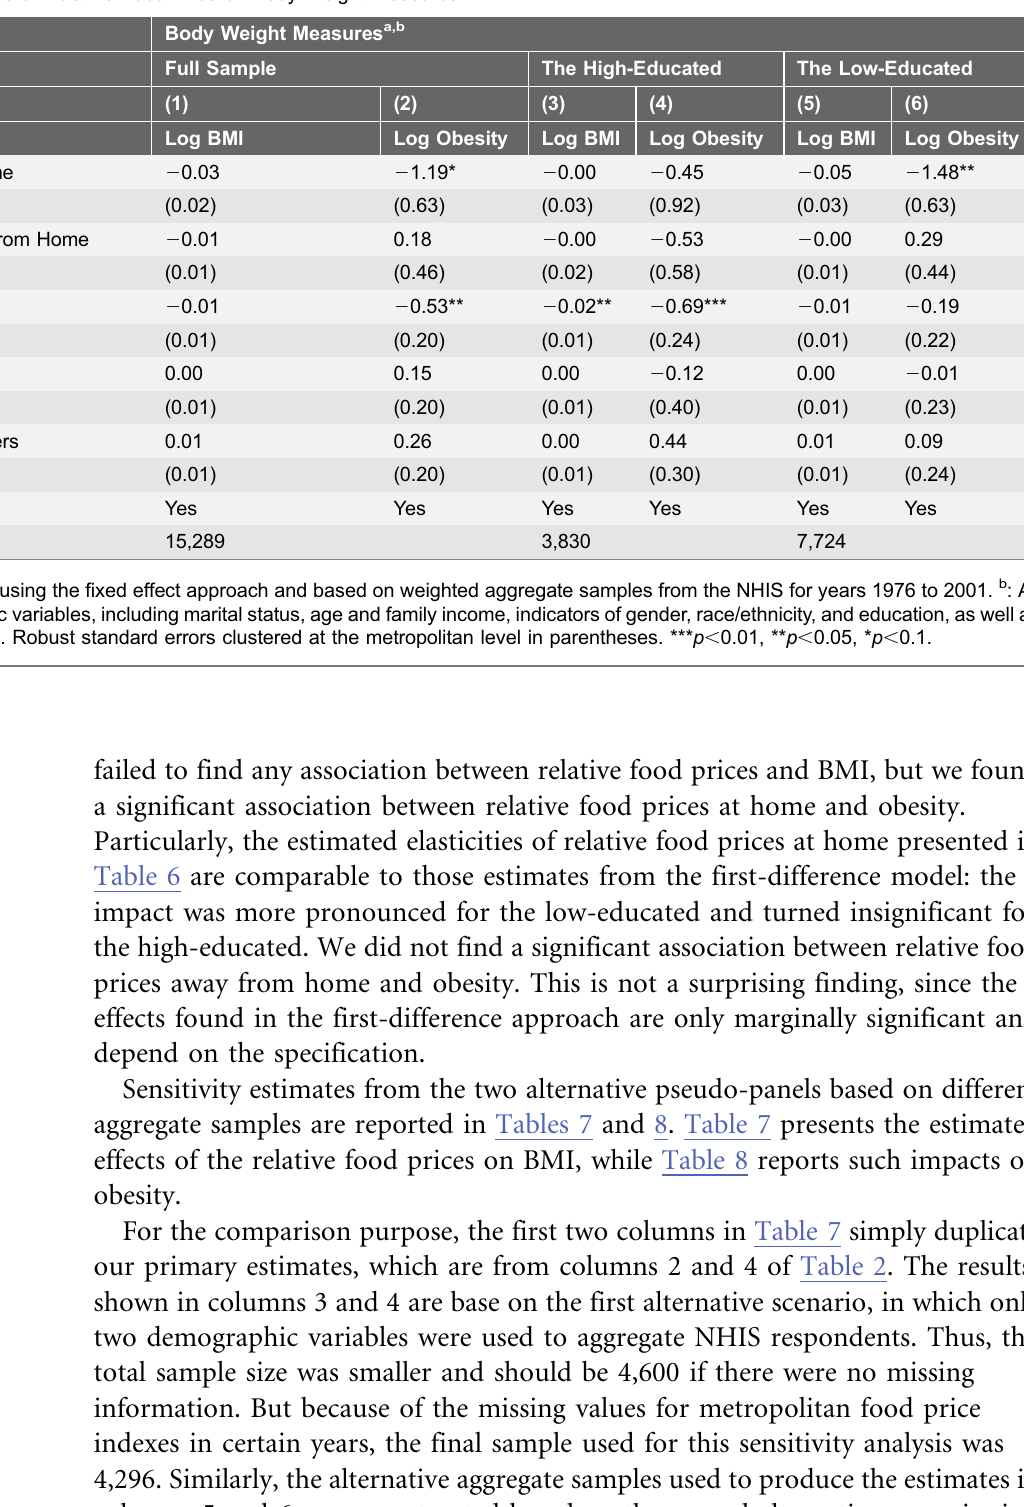
Table 6. The Fixed Effect Estimates of Relative Food Price on Body Weight